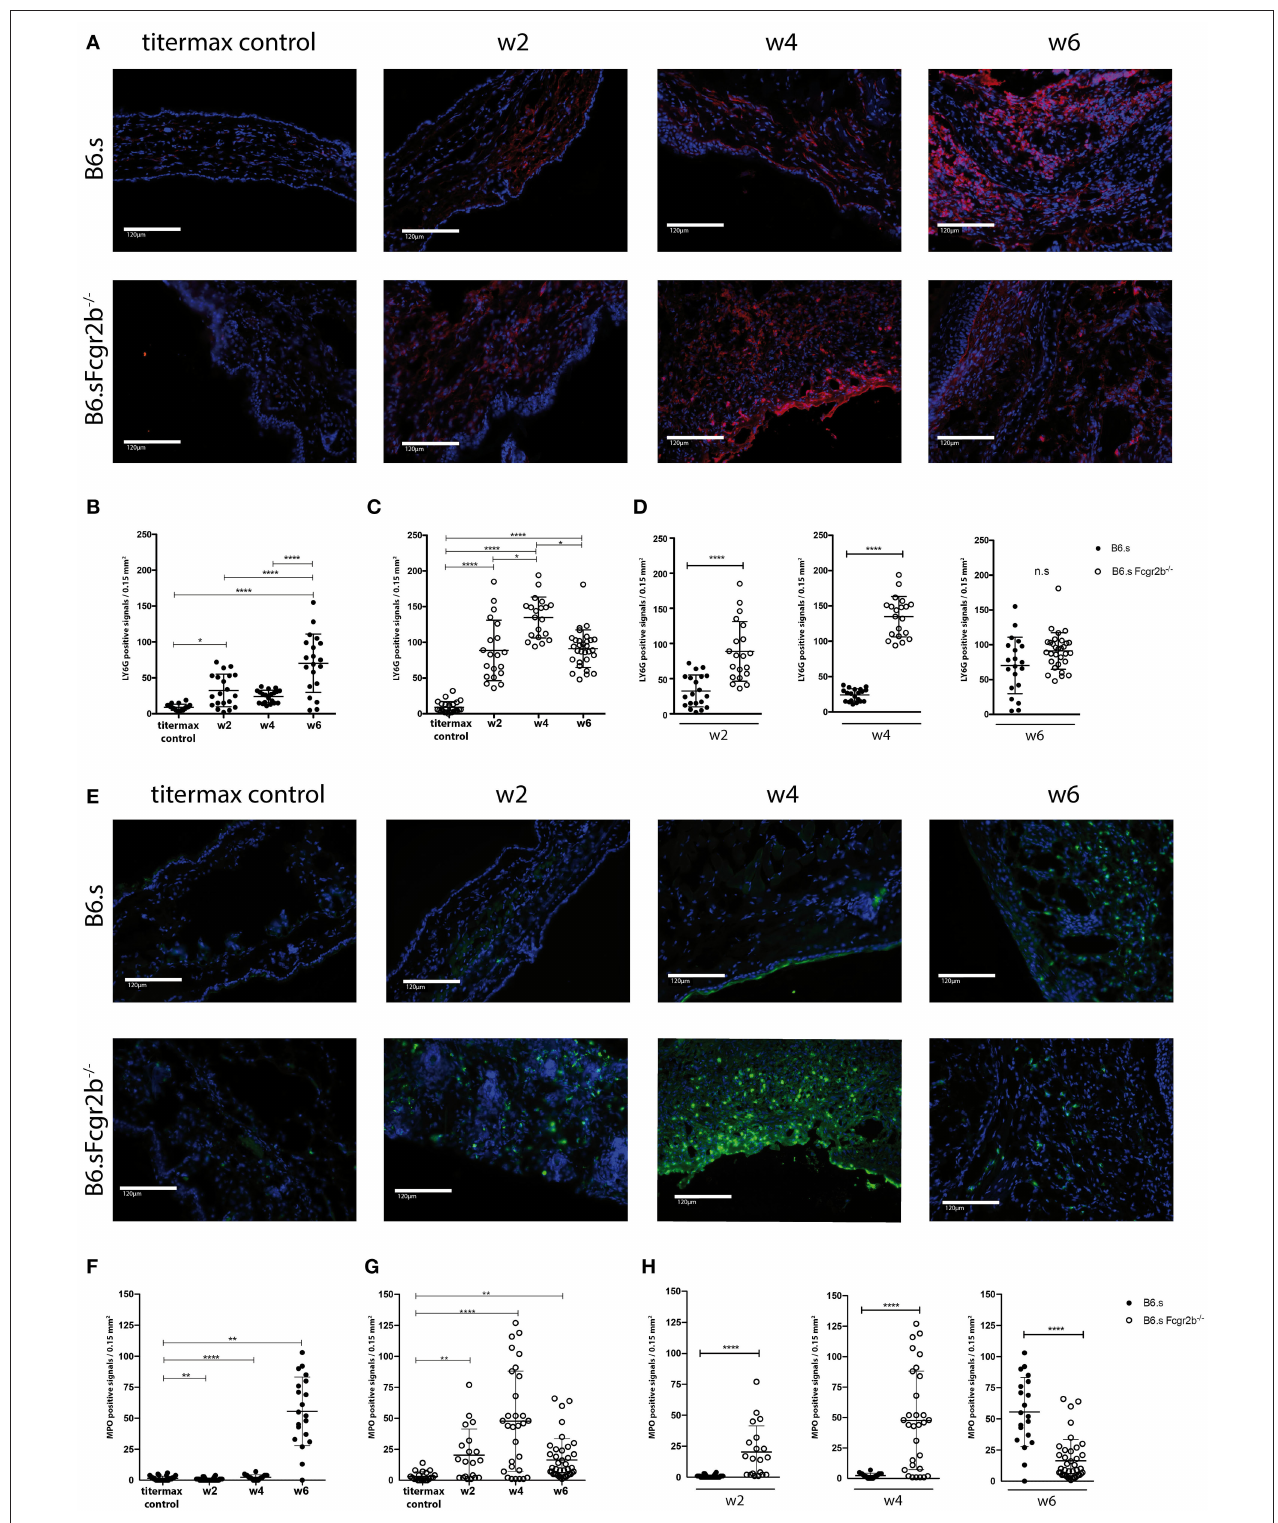
FIGURE 4 | Strong early migration of Ly6G + neutrophils to and MPO induction in the skin of B6.s- Fcgr2b − / − but not B6.s wt mice. (A) Presence of Ly6G + neutrophils in the skin of B6.s wt and B6.s- Fcgr2b − / − mice. Representative immunofluorescence staining of ear sections taken 2, 4, and 6 weeks after immunization with